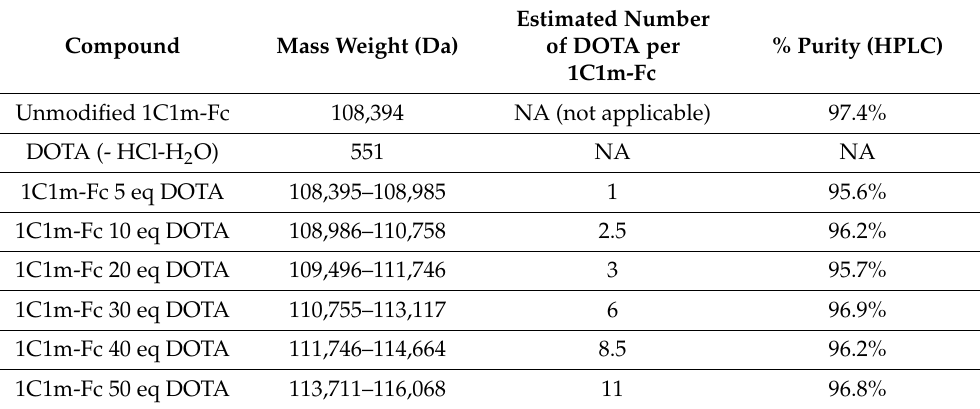
Table 1. Estimated number of DOTA per 1C1m-Fc based on mass spectrometry and purity analyses of the conjugates from 5 to 50 equivalents (eq) of DOTA. The estimated DAR is calculated using the formula: Σ ( n *Int)/ Σ (Int), where n = number of attached molecules for this peak, Int = intensity of the